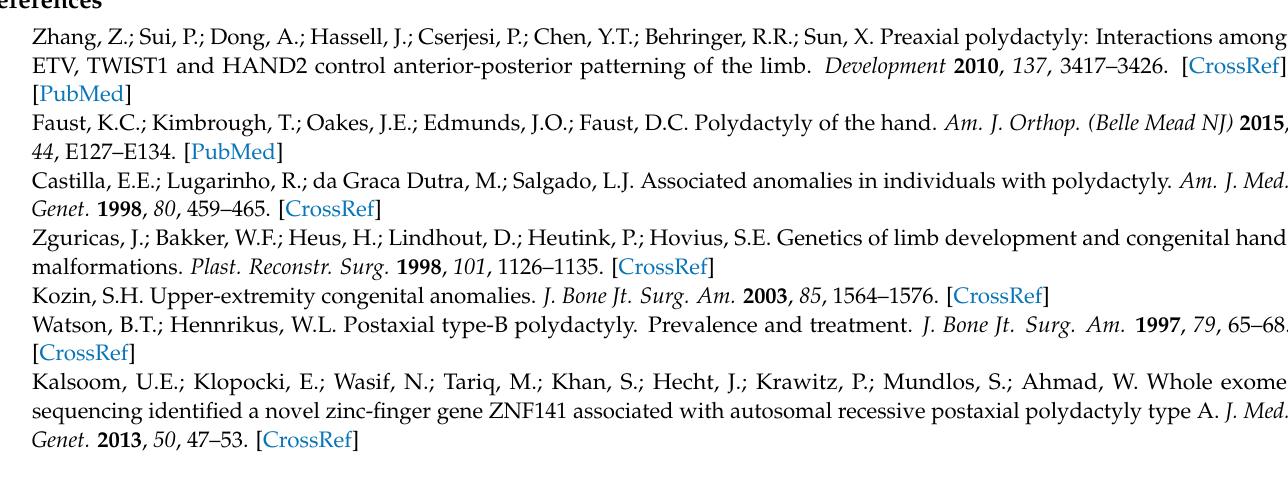
finger motifs; Figure S2: Ramachandran plot of ZNF141; C2-H2 domain (Res 171-474) with all the residues in Preferred and allowed regions and no residue in the disallowed region; Figure S3: ERRAT validation graph showing an overall quality score of the structure as 92.491 with the low relatively low confidence score of the error for the rest of the residues; Figure S4: The potential energy of both wt-ZNF141 and T474I models after energy minimization; Figure S5: Secondary structure analysis of (A) wt-ZNF141 and (B) mutant T474I protein after 100ns molecular dynamics simulations; Figure S6: ( a ) The figure shows the schematic structures of the original (left; threonine) and the mutant (right; isoleucine) amino acid. The backbone, which is the same for each amino acid, is colored red. The side chain, unique for each amino acid, is colored black; ( b ) Superimposition of wild-type and mutant-type residues at 474th position. The wild type of threonine is shown in sticks while mutant Isoleucine is shown in Lines; Table S1: Functional impact of ZNF141 T474I mutation predicted by different